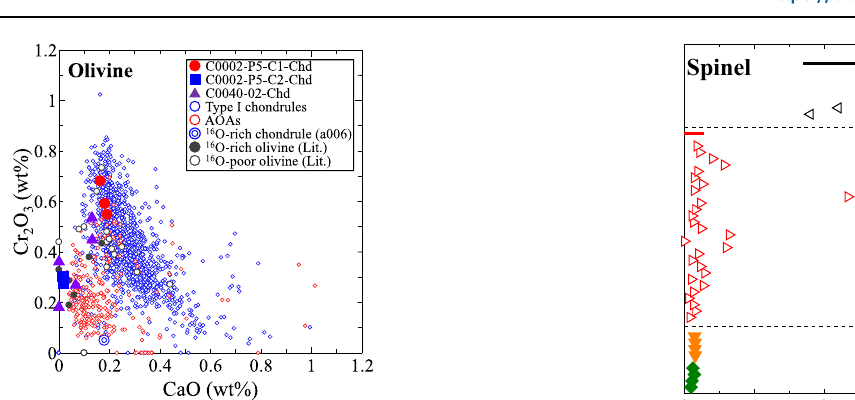
Fig. 4 | Comparison of concentrations between Cr 2 O 3 and CaO in olivine from the three chondrule-like objects in the Ryugu samples. Concentrations of Cr 2 O 3 and CaO in olivine from C0040-02-Chd are only from TEM-EDS data, as the EPMA data is mixture of olivine and diopside. Olivine data of type I chon- drules and AOAs, which are plotted for comparison, are from type ≤ 3.0 chondrites 10,16,17,21,36,37,42,43,45,46,49,51,55,56,71,80 – 86 . Concentrations of Cr 2 O 3 and CaO in olivine in the 16 O-rich chondrule (a006) from a CH chondrite 50 and those in 16 O-rich and -poor olivine from the Ryugu samples and CI chondrites 22 – 24,30,41 are plotted for